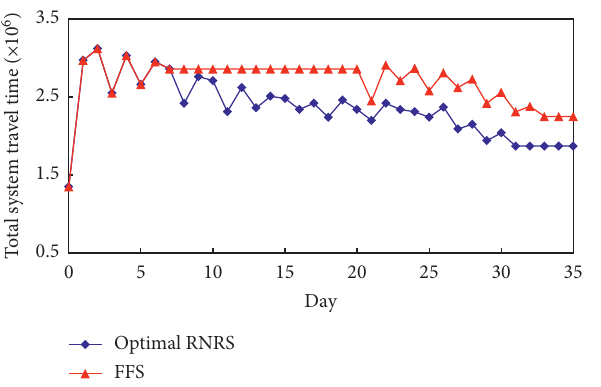
Figure 10: Total system travel time evolution trajectories of the optimal RNRS and FFS.